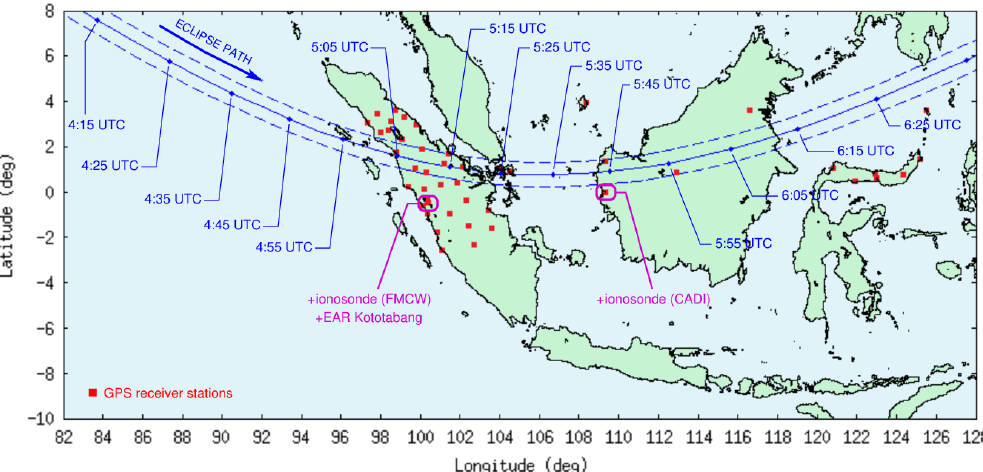
Figure 1. Geographical map showing the path of the 26 December 2019 annular solar eclipse over Southeast Asia as well as a suite of ground-based radio diagnostic instruments used in the